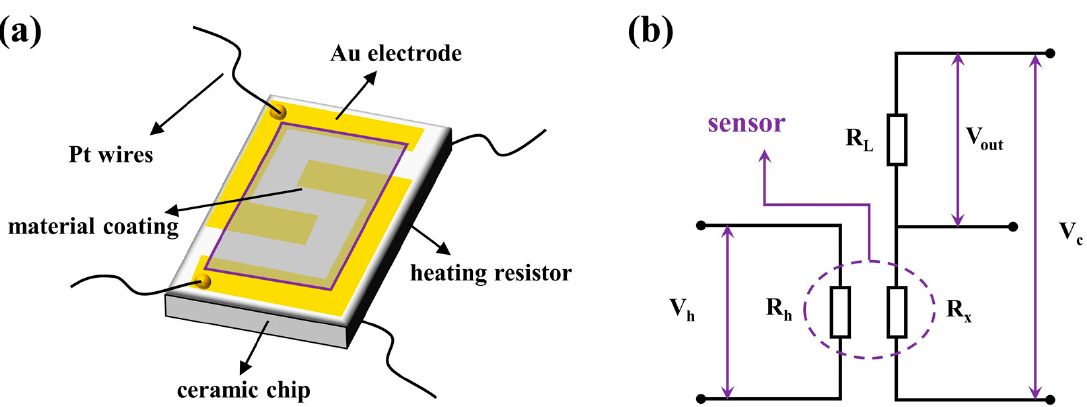
Figure 2. ( a ) Schematic diagram of gas sensor element and ( b ) the sensor testing principle.